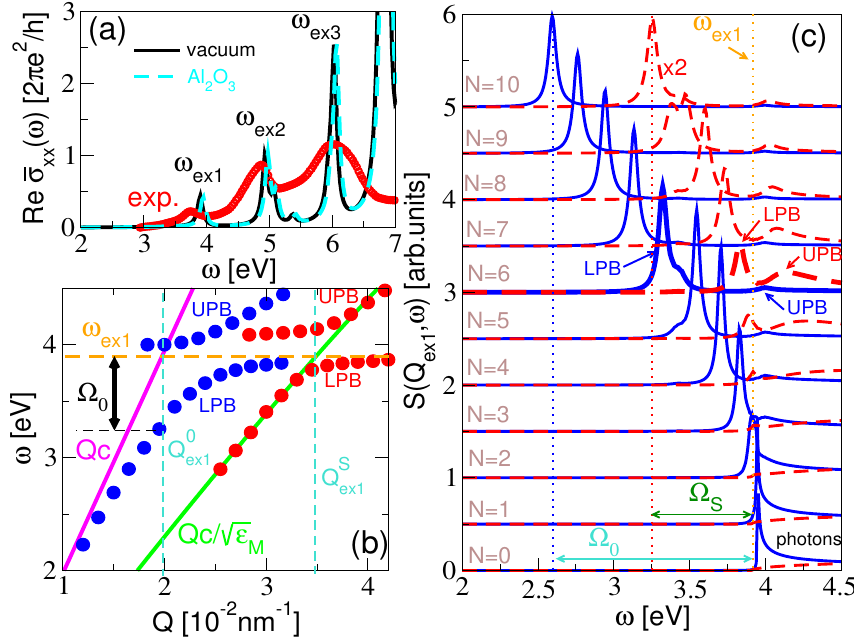
Figure 4. ( a ) The optical conductivities ˜ σ xx ( ω ) in the C 60 single layer in vacuum (black solid), in the C 60 single layer at the Al 2 O 3 dielectric surface (cyan dashed) (where z 0 = 6.5 Å), and the experimental optical absorption in the gas phase fullerene C 60 (red circles). ( b ) The lower and upper exciton–polariton branches, LPB and UPB, respectively, in the self-standing C 60 film (blue dots) and the C 60 film deposited at the Al 2 O 3 surface (red dots). The LPB corresponds to the dispersion relation of the exciton–polariton ω ex1-pol ( Q ) appearing in Equation (53). The number of C 60 layers is N = 6. ( c ) The spectra of the s(TE)-polarized electromagnetic modes S ( Q ex 1 , ω ) in the self-standing C 60 films = 0.02 nm − 1 (blue solid) and in the C = 0.035 nm − 1 (red for Q 0 60 films at the Al 2 O 3 surface for Q ex1 ex1 dashed). The number of the single layers is N = 0,1,2,3, . . . ,10, where the case N = 0 corresponds to the spectrum of the free photons in vacuum or at the vacuum/Al 2 O 3 interface (the photon continuum). All spectra for the supported films are multiplied by factor